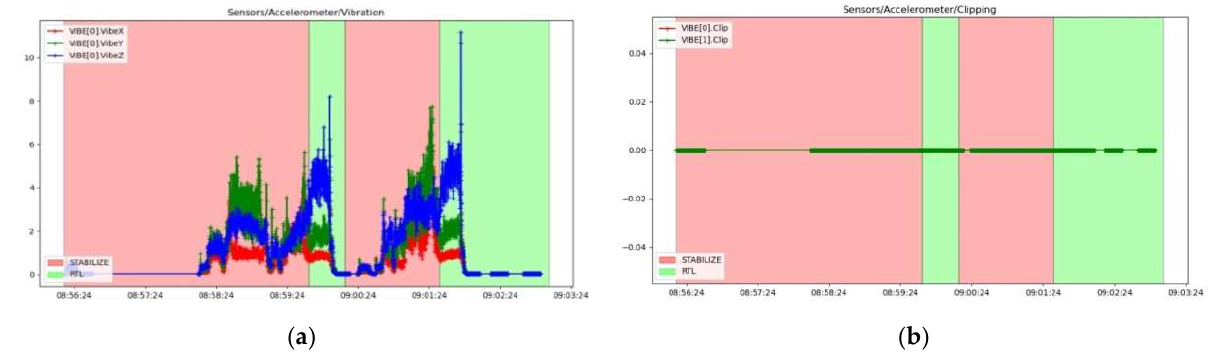
Figure 30. Vibration and clipping. ( a ) Accelerometer (0); ( b )